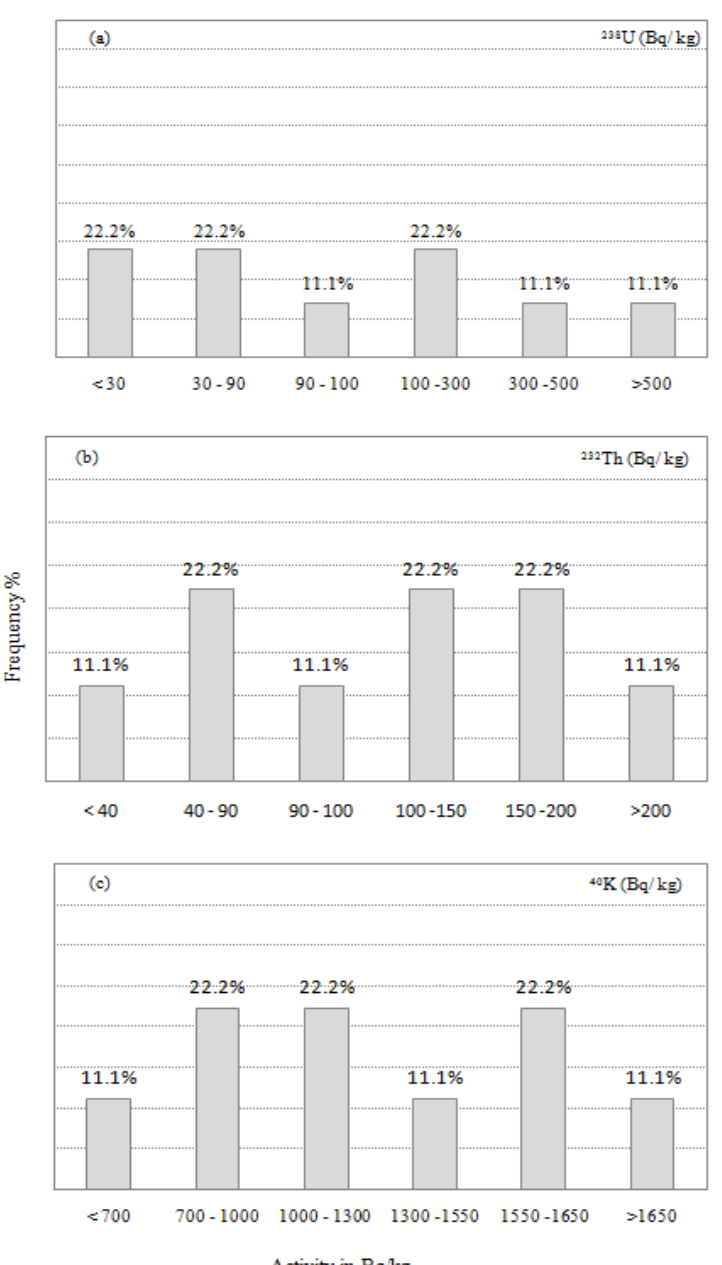
Figure 3. Frequency distributions of activity concentrations (Bq kg − 1 ) for the Sol Hamed fine-grained granite: ( a ) 238 U; ( b ) 232 Th; ( c ) 40 K.